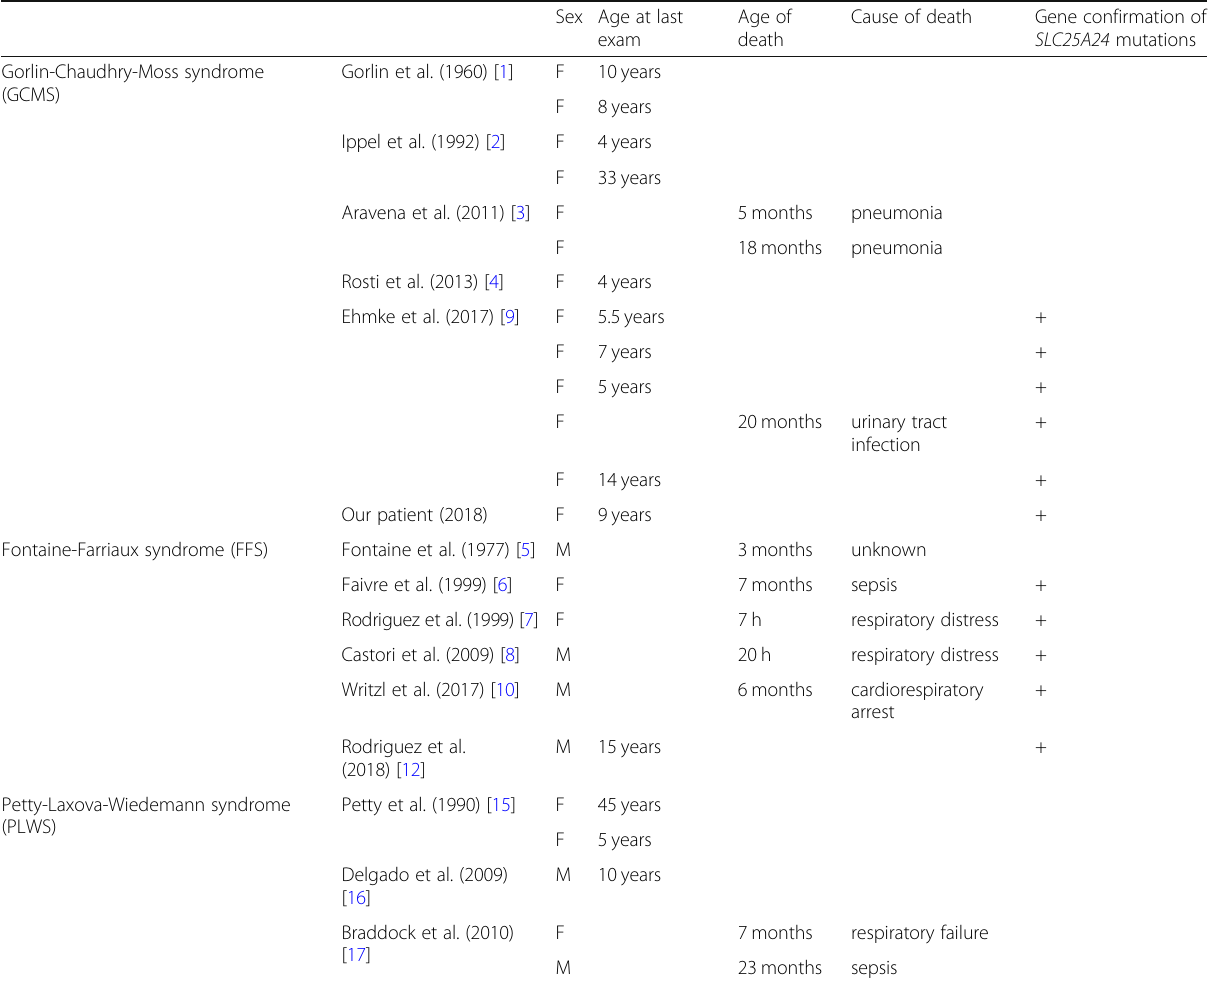
Sex Age at last Age of Cause of death Gene confirmation of SLC25A24 mutations exam death